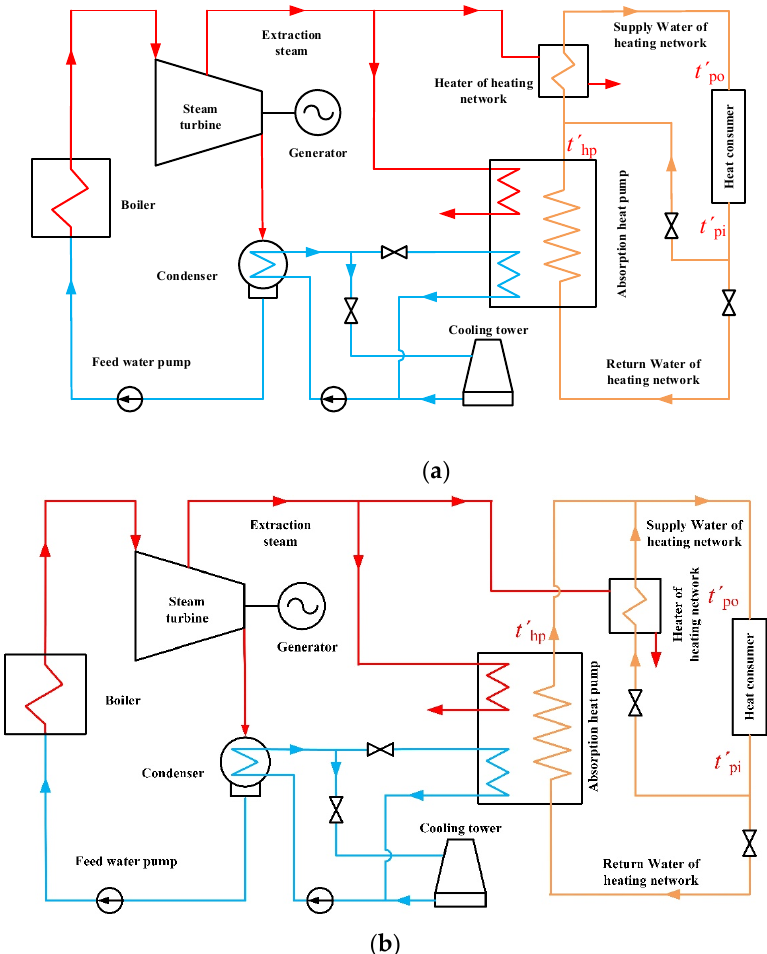
Figure 1. The heating supply system with the waste heat recovery system using an absorption heat pump: ( a ) series connection type, ( b ) parallel connection type.